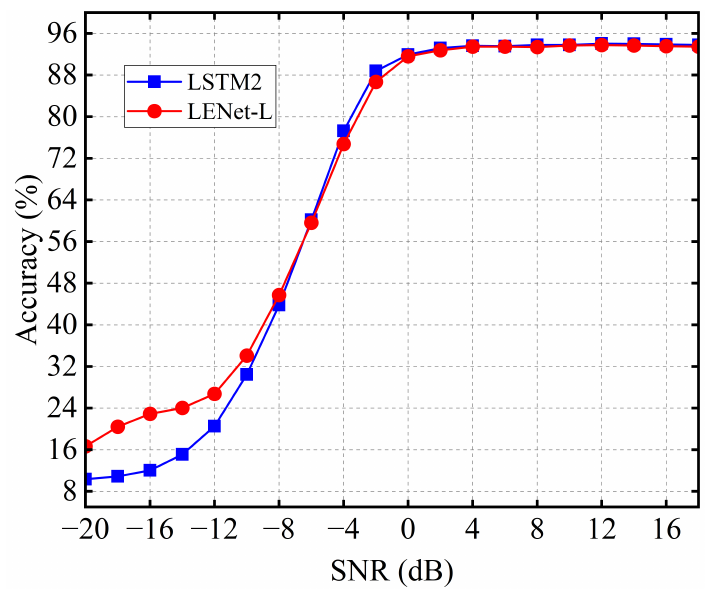
Figure 11. Comparison of LSTM2 and LENet-L on the 2016B